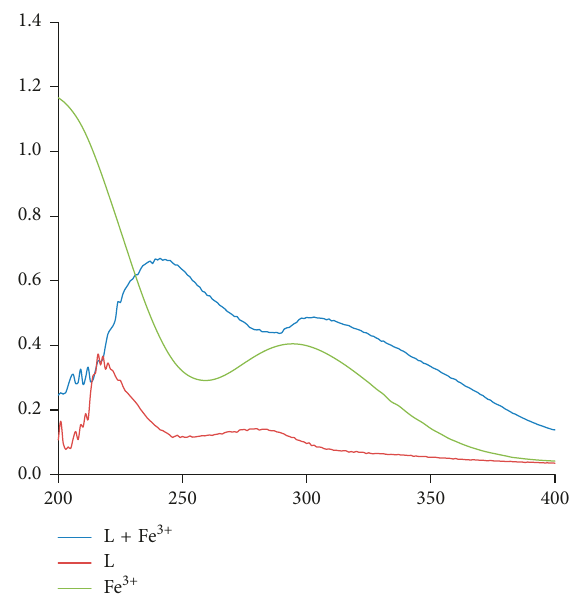
Figure 3: UV-Vis spectra of ligand (L), Fe 3+ , and Fe 3+ complex. Table 1: λ max of various transitions in the derivative (L) and iron complex.